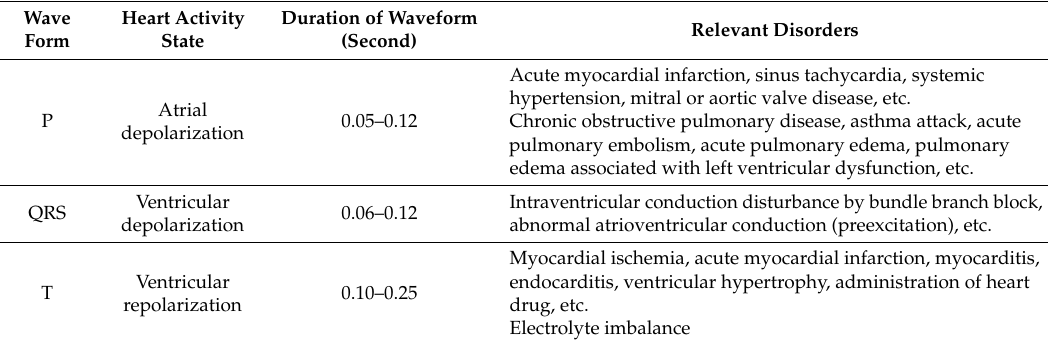
Table 1. Duration and related diseases by type of ECG